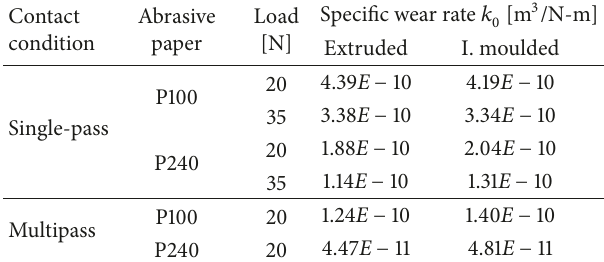
Table 4: Specific wear rate for extruded and injection moulded